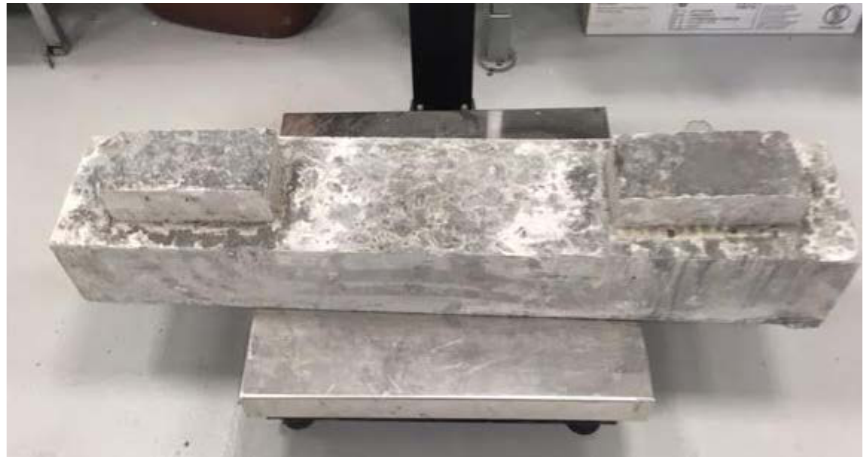
Figure 9. Laboratory sample prepared for testing.